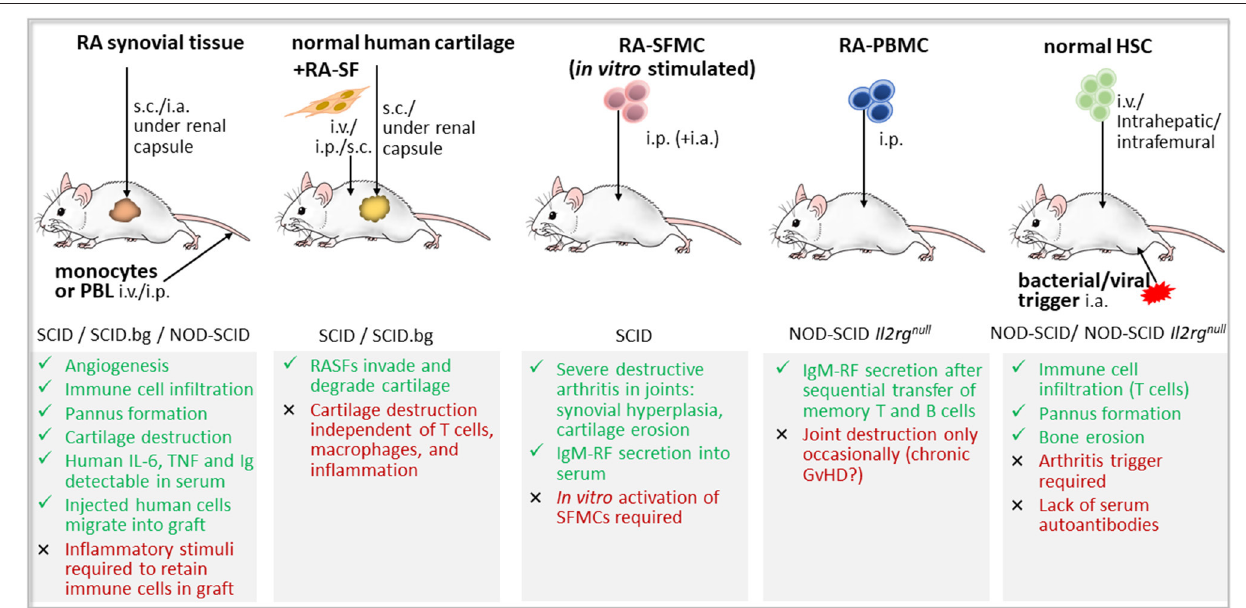
FIGURE 3 | Humanized mouse models of rheumatoid arthritis based on the engraftment of human cells and/or tissues in immunodeficient mice. RA-like features (green color) and drawbacks (red color) of the five main approaches for the development of a humanized mouse model of rheumatoid arthritis (RA). First, transplantation of RA synovial tissue and eventual co-injection of peripheral blood lymphocytes (PBL) or monocyte cell line; Second, co-implantation of normal human cartilage and RA patient-derived synovial fibroblasts (RA-SF); Third, injection of synovial fluid mononuclear cells (SFMCs) from RA patients, either stimulated in vitro or not; Fourth, inoculation of RA patient-derived peripheral blood mononuclear cells (PBMCs); and fifth, induction of RA-like disease by viral or bacterial triggers in immunodeficient mice that have been reconstituted with human hematopoietic stem and progenitor cells (HSCs). GvHD, graft vs. host disease; i.a., intraarticular; Il2rg null , defective interleukin 2 receptor γ chain; i.p., intraperitoneal; i.v., intravenously; NOD, non-obese diabetic mouse; s.c., subcutaneously; SCID, severe combined immunodeficiency; SCID.bg, SCID mouse with reduced NK cell activity due to beige